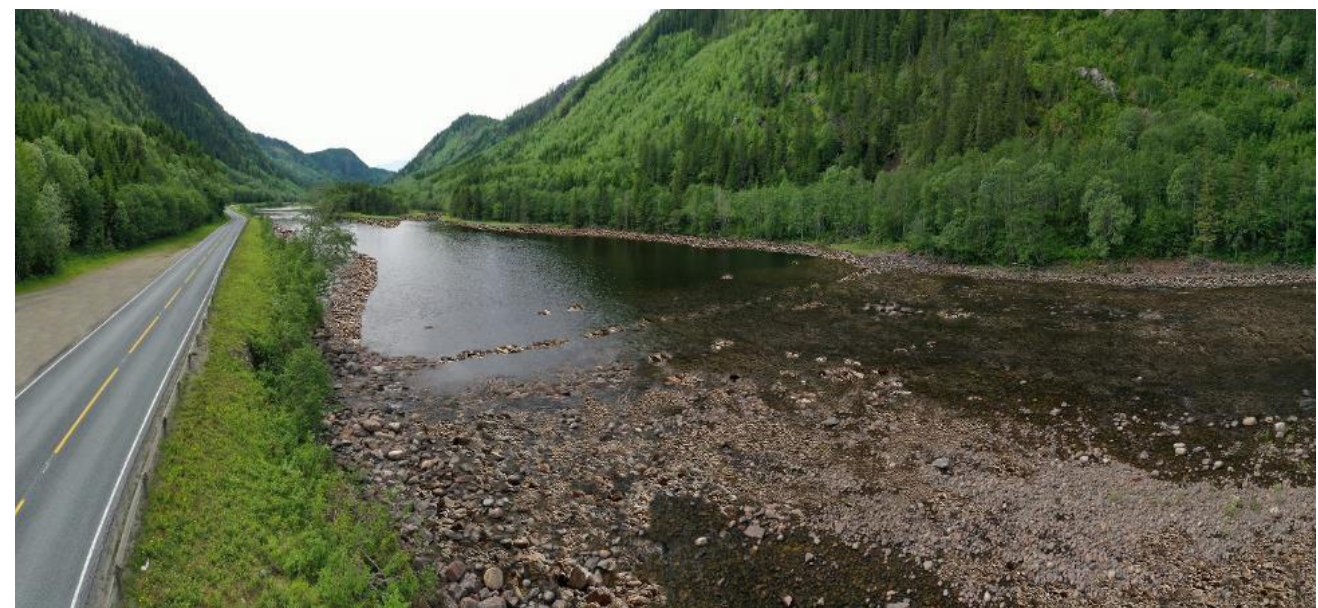
Figure 7. The same scenario as shown in Figure 6 from an aerial perspective (visual scenario: Rolseth Foto).